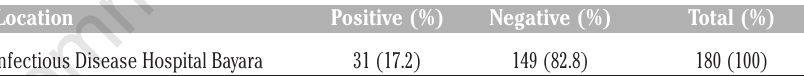
Table 1. Distribution of hepatitis B surface antigen within the population screened.